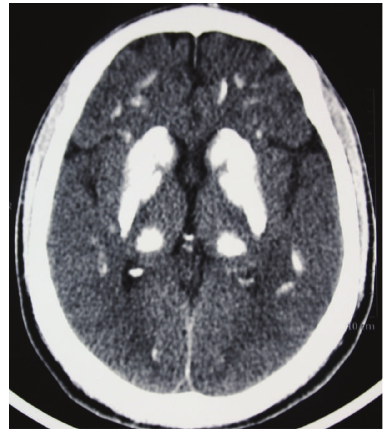
Figure 1: Bilateral symmetrical calcifications on cranial